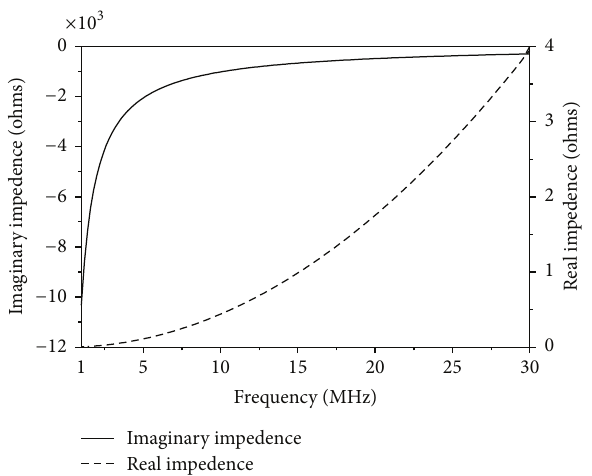
Figure 1: Real and imaginary parts of input impedance of the monopole antenna.